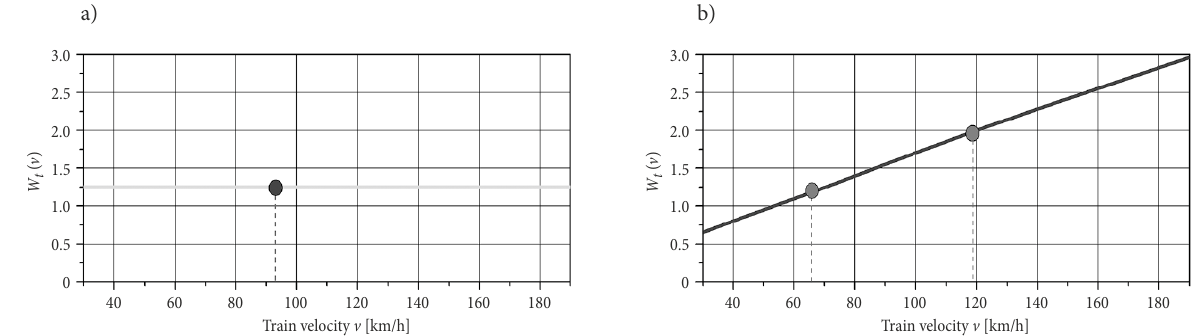
Fig. 2. Theoretical (a) and experimental (b) dependence of velocity on the